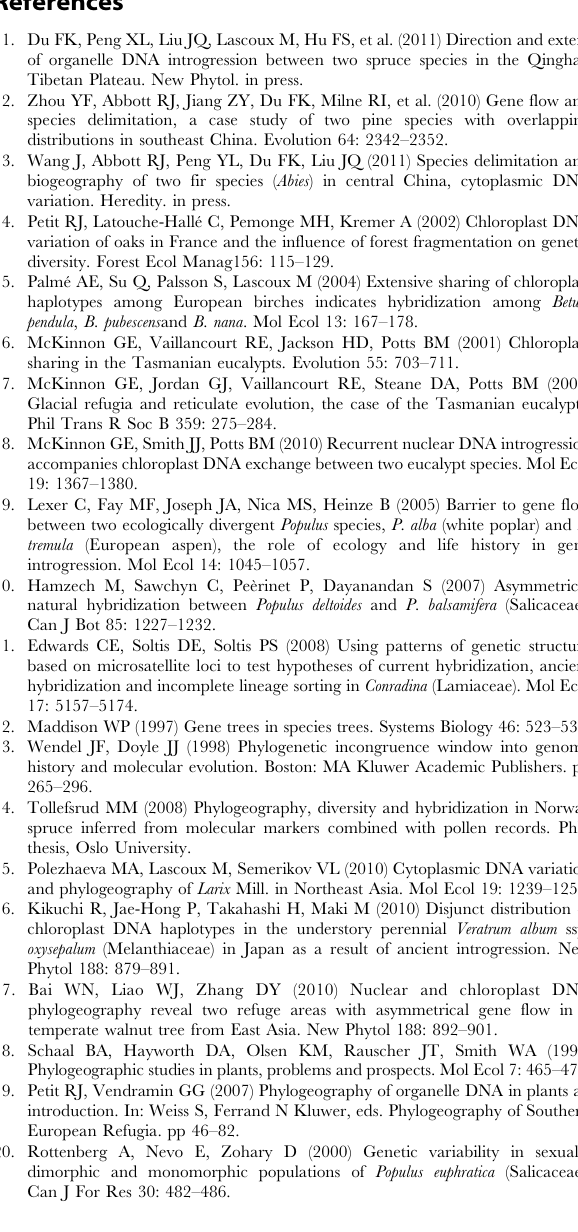
Table S5 Characteristics of eight polymorphic micro- satellite loci for P. euphratica and P. pruinosa. (DOC) Table S6 Genetic variation within populations of P. euphratica and P. pruinosa based on eight SSR